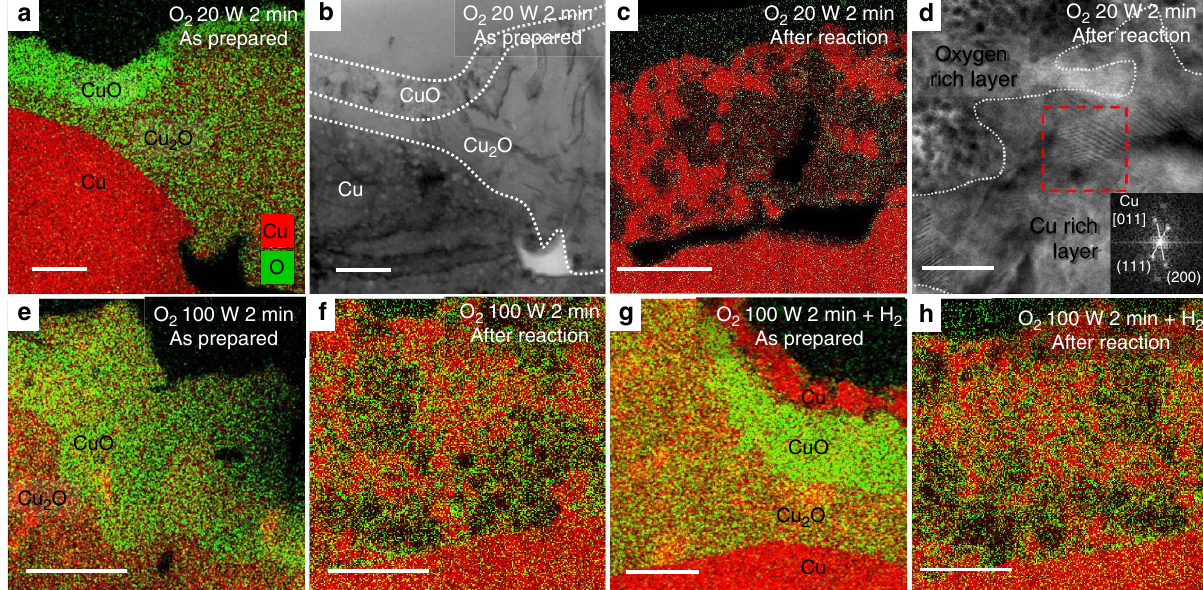
Figure 2 | Morphological and chemical analysis of plasma-activated Cu foils. EDS elemental maps of Cu foils treated with O 2 plasma for ( a – d ) 20W 2min; ( e – f ) 100W 2min; and ( g – h ) 100W 2min þ H 2 plasma. The images labelled ‘after reaction’ were used as catalyst for CO 2 RR for 1h at (cid:2) 0.91V versus RHE. ( b , d ) HRTEM and SAED analysis of the O 2 plasma 20W 2min treated sample before and after the reaction, respectively. Scale bars, ( a – c ) 300nm; ( d ) 20nm; ( e – h ) 200nm.